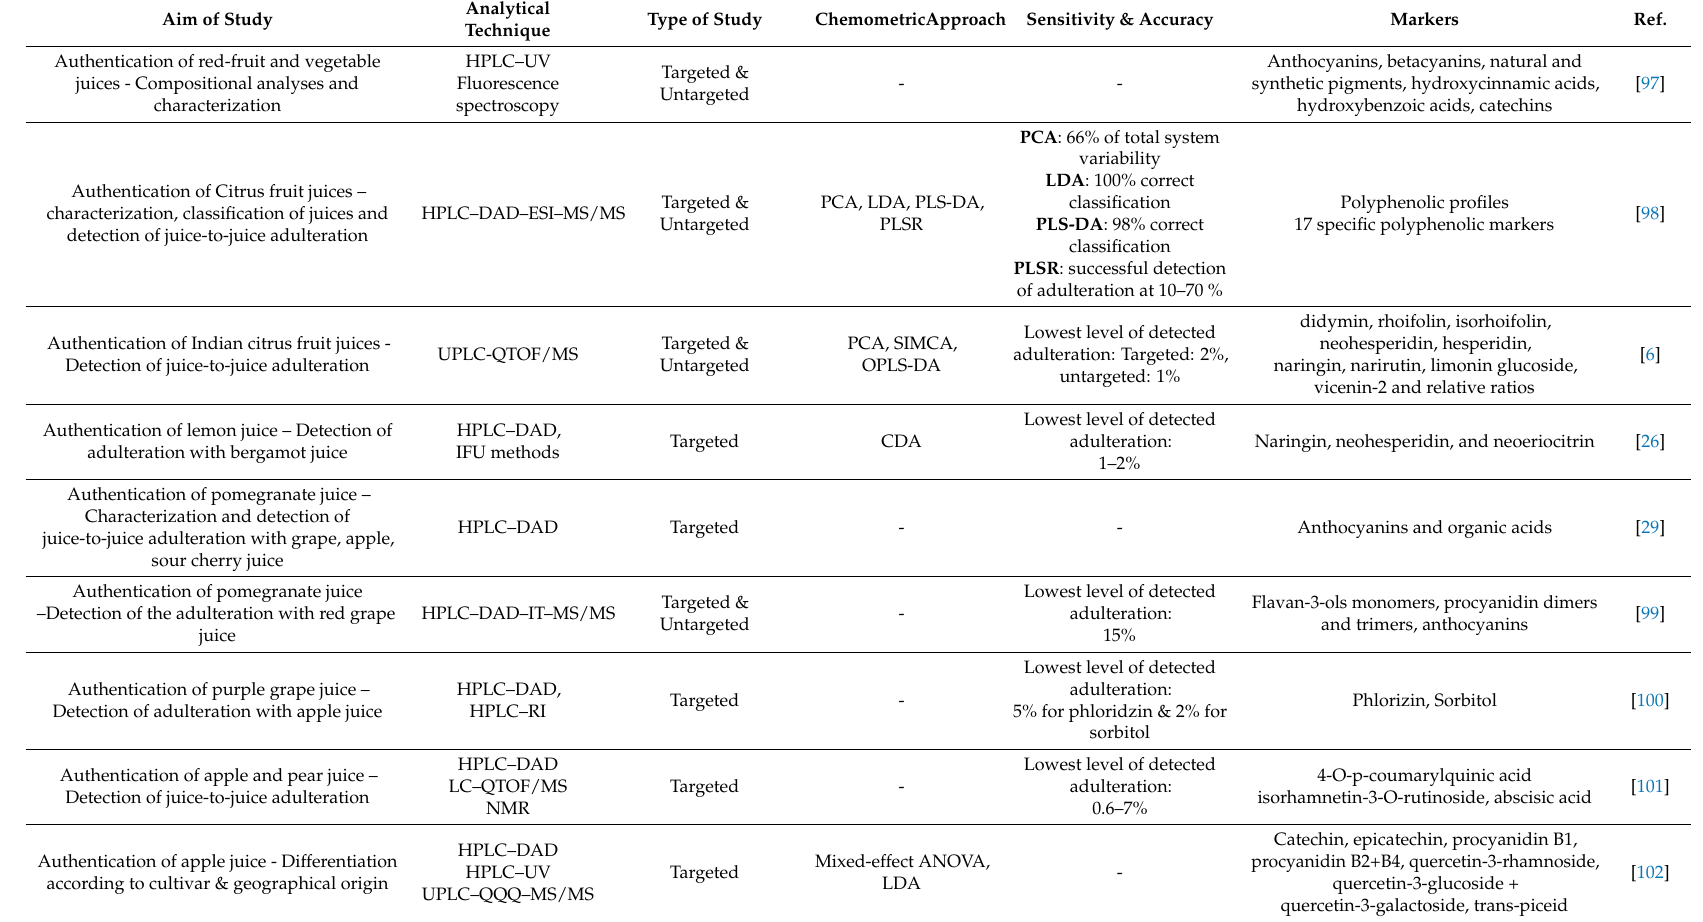
Table 5. Applications of Liquid Chromatography to authenticity studies of fruit